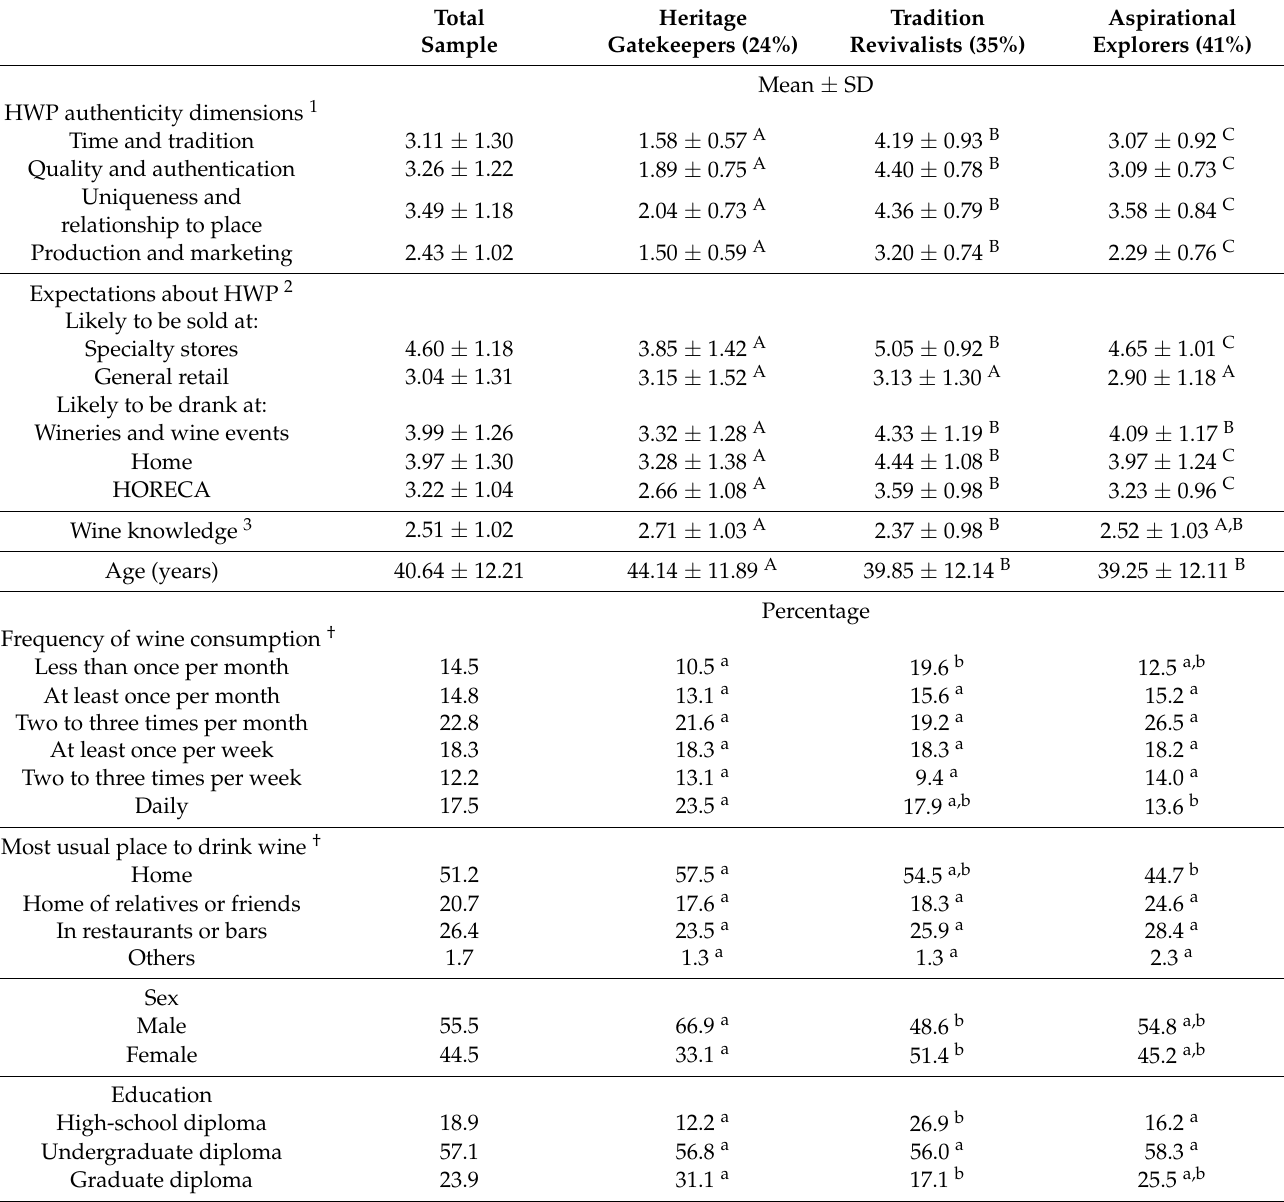
Table 3. Profiles of groups of questionnaire respondents obtained by clustering HWP authenticity dimension regression scores ( n =